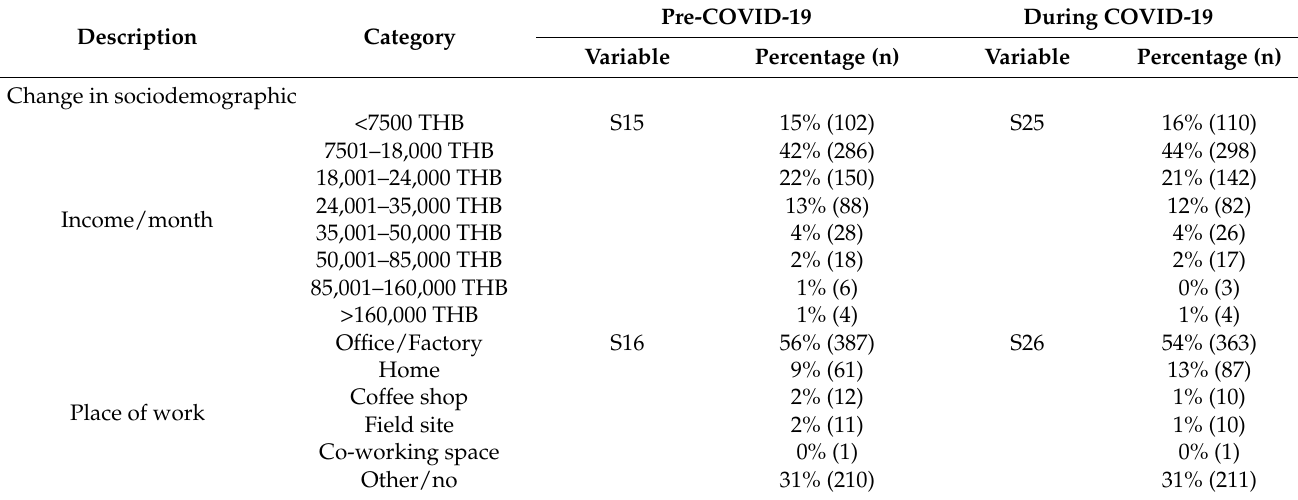
Table 2. Characteristics of behavior changes of